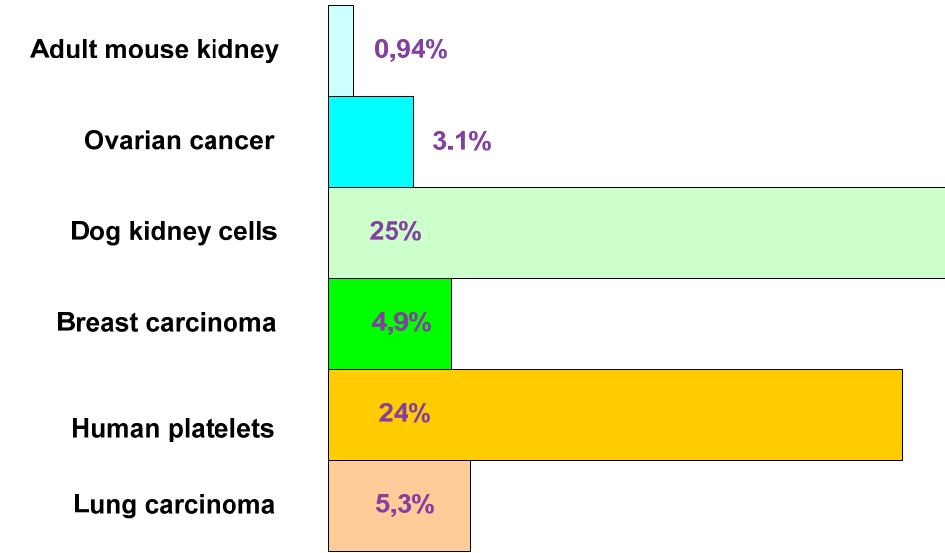
Figure 1. Glycolytic ATP contribution in tumour and normal cells expressed as a percentage of total ATP production (based on Zu and Guppy [38]).